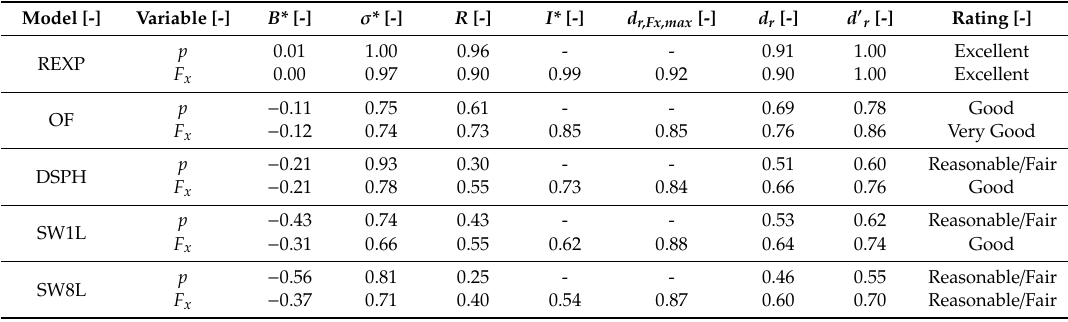
Figure 13. Comparison of d r evaluated for p (of REXP, OF, DSPH and SW1L with reference to EXP) at the vertical wall (horizontal axis). Adapted from the work in [3], with permission from the authors, 2020. Table 4. Model performance and pattern statistics evaluated for p and F x of REXP, OF, DSPH, SW1L and SW8L at the respective measured locations PS05 and LC. Adapted from the work in [3], with permission from the authors,